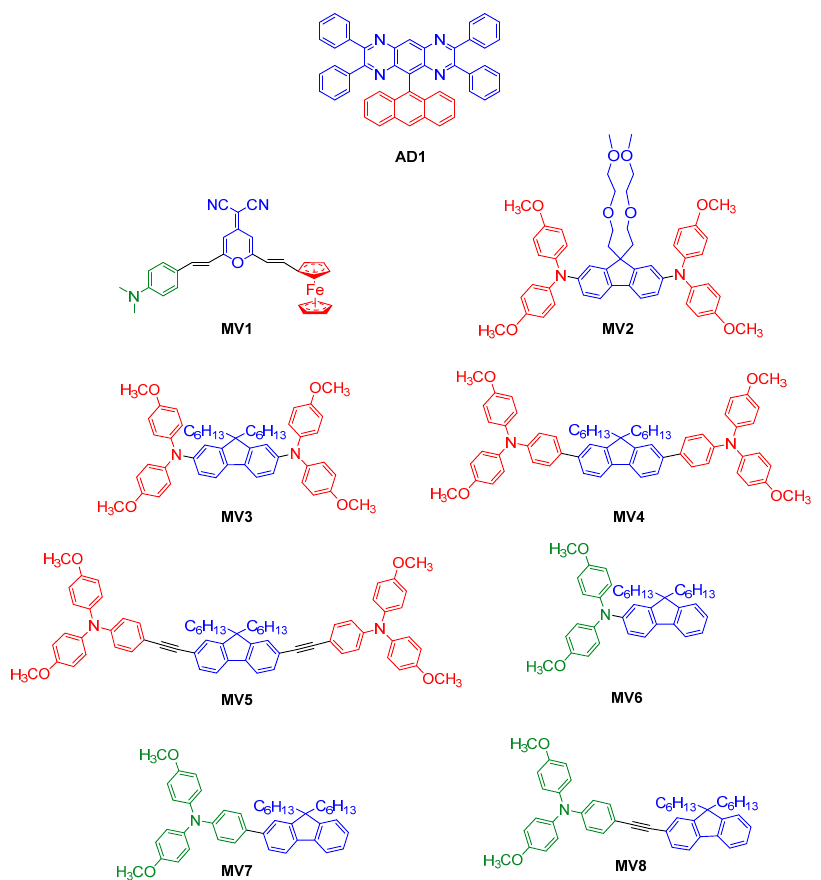
Figure 6. Molecular dyads and mixed ‐ valence fluorophores consisting of a fluorophore (blue) and electroactive segments (red and green) examined as molecular electrofluorochromes